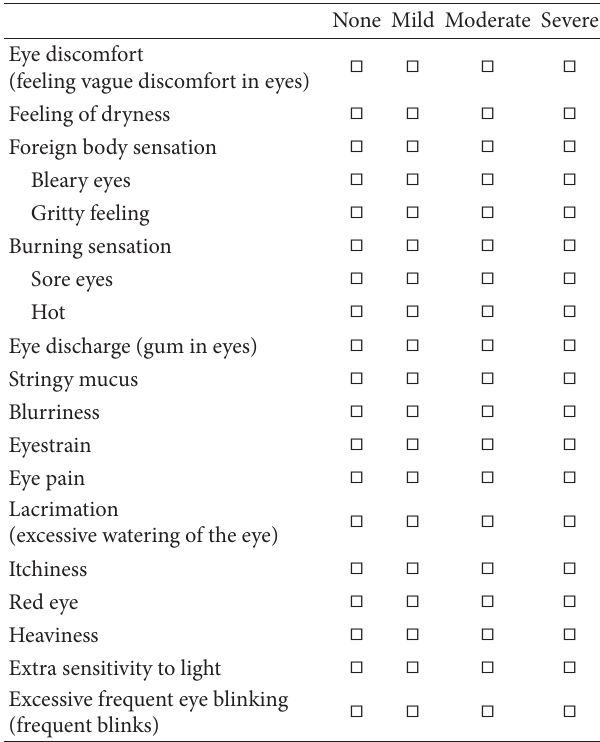
Table 1: Participants’ demographic characteristics. Table 2: Ocular symptoms questionnaire. Data were obtained before and 4 weeks after Eye Shampoo group